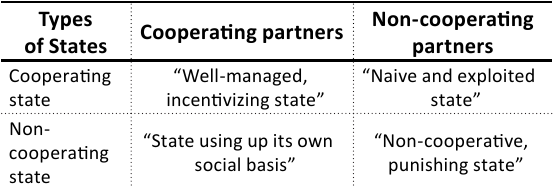
Table 1. Cooperation matrix for the state and